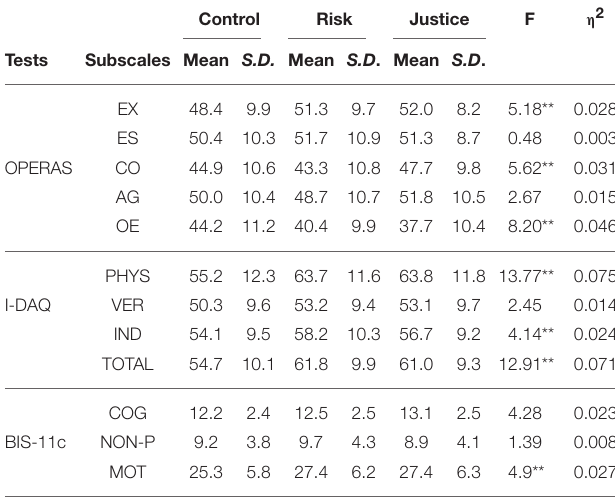
TABLE 2 | Descriptive statistics for the personality measures in the three samples and ANOVA/ANCOVA analyses.